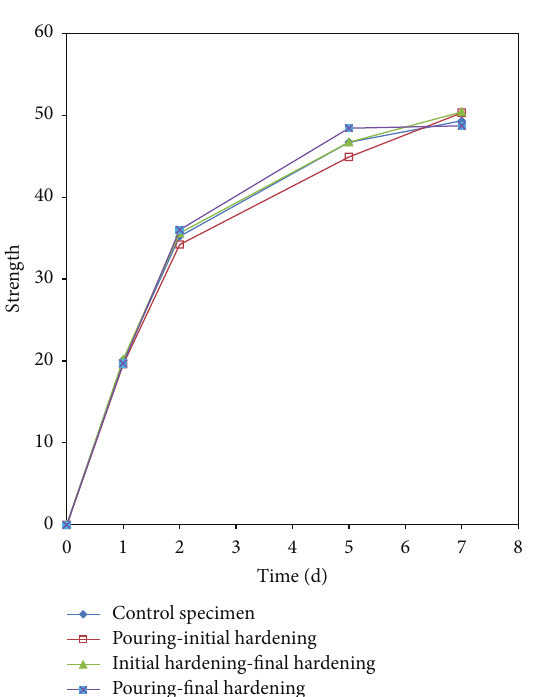
Figure 7: Compressive strength and rate of change of HPC speci- mens with vibration parameters of 4 Hz and